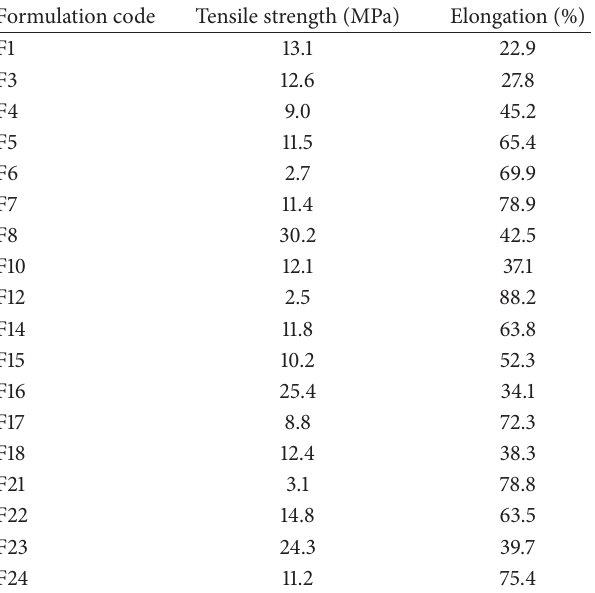
Table 4: Mechanical properties of OS of DSL. Formulation